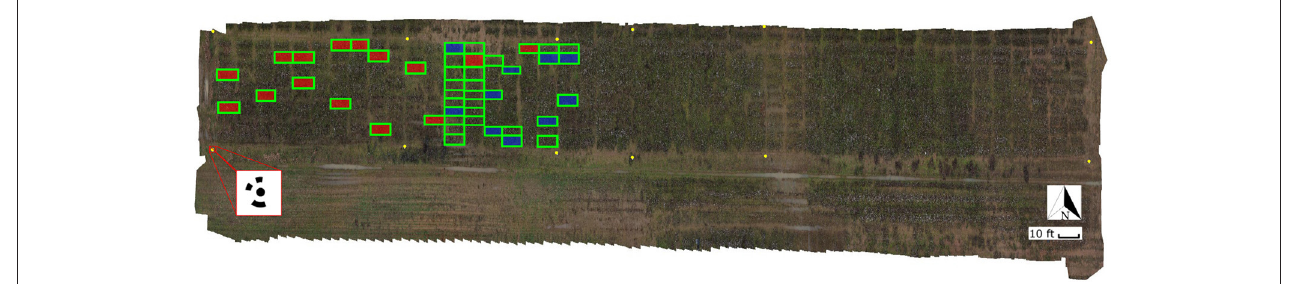
FIGURE 3 | General orthomosaic map of the experimental field. Ground Control Points (GCP) used for image geo-referencing are identified as yellow circles; a total of 12 GCPs were used around the field. The red square at the bottom-left corner shows a zoom-in view of one of the 60 × 60 cm square GCPs with the 12-bit circular coded pattern. Ground truth plots measured on February 2, 2020 using digital approaches are identified with green boxes (45 plots). Plots harvested on February 3, 2020 are identified with boxes filled in red (15 plots); ground truth plots harvested on February 27, 2020 are identified with boxes filled in blue (10 plots).